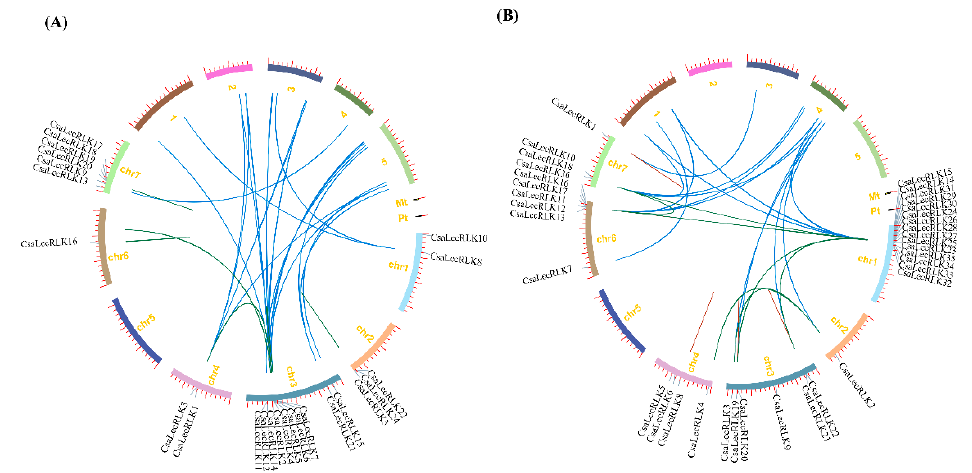
Figure 3. The collinear relationship of ( A ) L-type LecRLK and ( B ) G-type LecRLK proteins between cucumber and Arabidopsis (indicated with blue lines), and within cucumber (indicated with green color). The red line indicates tandem duplication between G-type LecRLK proteins of cucumber.